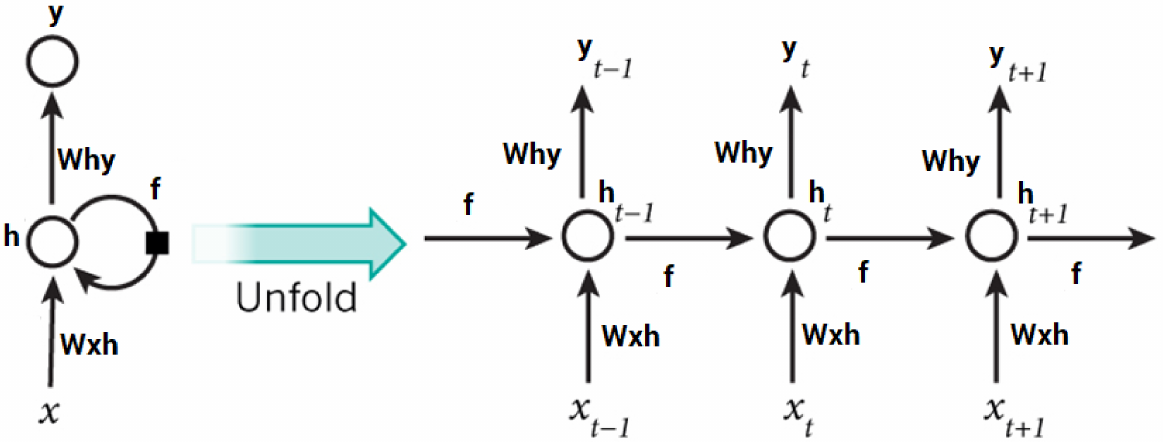
Figure 5. Structure of the LSTM